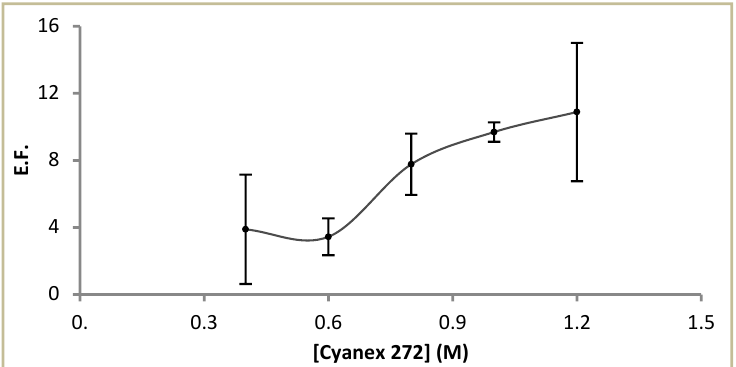
Figure 4. Effect of Cyanex ® 272 concentration on the enrichment factor. Sample: 0.1 µg L −1 Cd 2+ in NaNO 3 1 M and HEPES 0.1 M. Acceptor solution: HNO 3 1 M. Extraction time: 180 min. Fiber length: 6 cm. Stirring rate: 200 rpm .